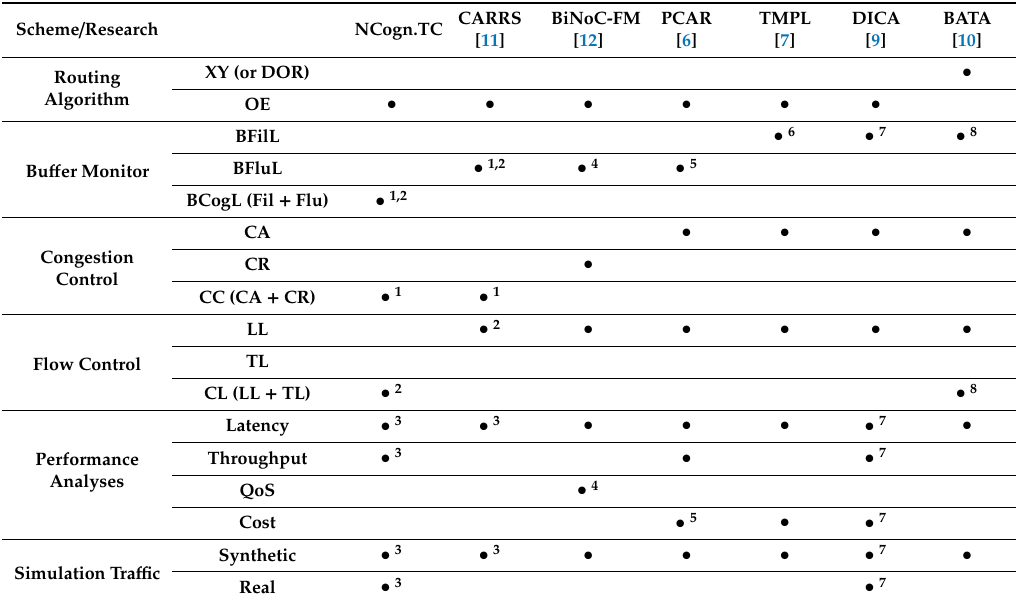
Table 3. Comparisons among the proposed NCogn.TC and other